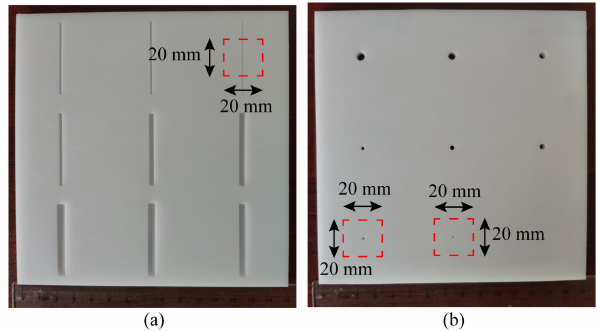
Figure 10. The two POM boards with di ff erent defects, and the regions of red rectangles are to be imaged: ( a ) The POM board with the cracks of di ff erent widths; ( b ) The POM board with the vias of di ff erent diameters.